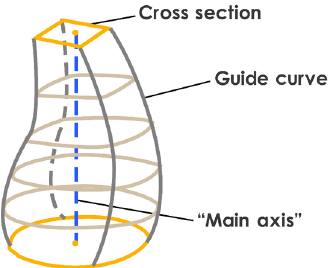
Fig. 1 A lofting surface. Differing from the concept of lofting surfaces used in CAD systems, we additionally define a “main axis” orthogonal to the cross sections.